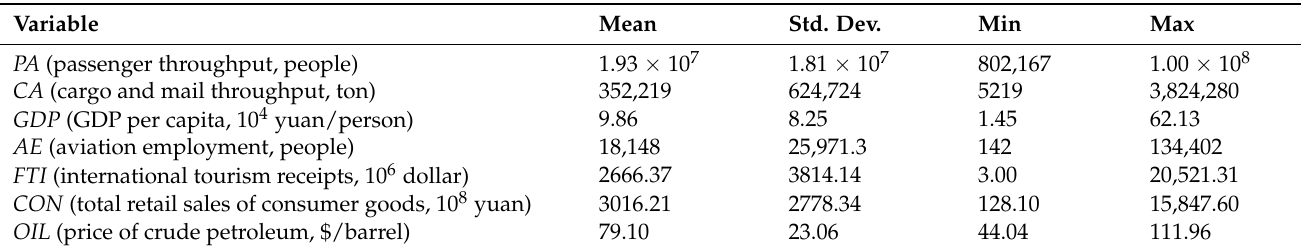
Table 1. Definition of the variables.